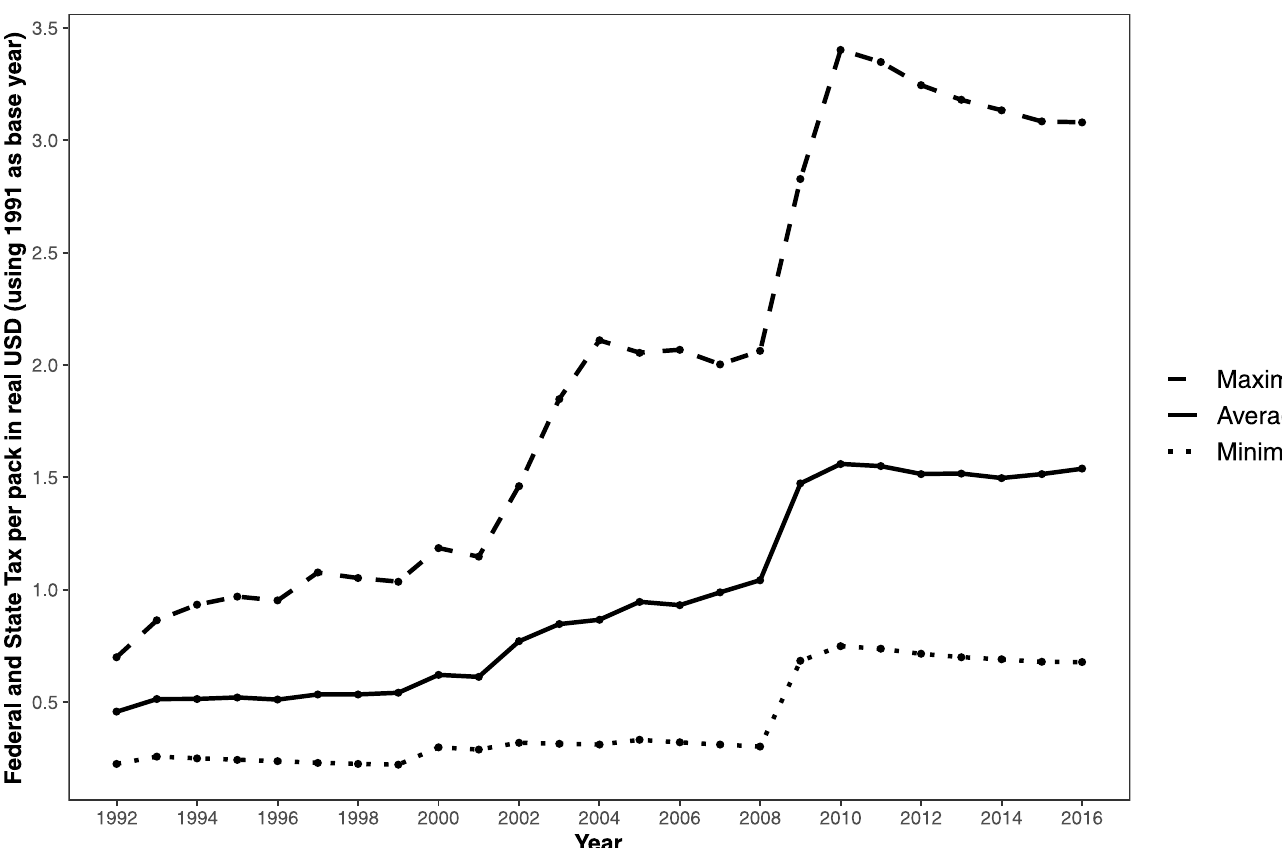
Fig 1. Real tobacco excise taxes (1991 $) levied per pack of 20 cigarettes in US states (1992–2016).